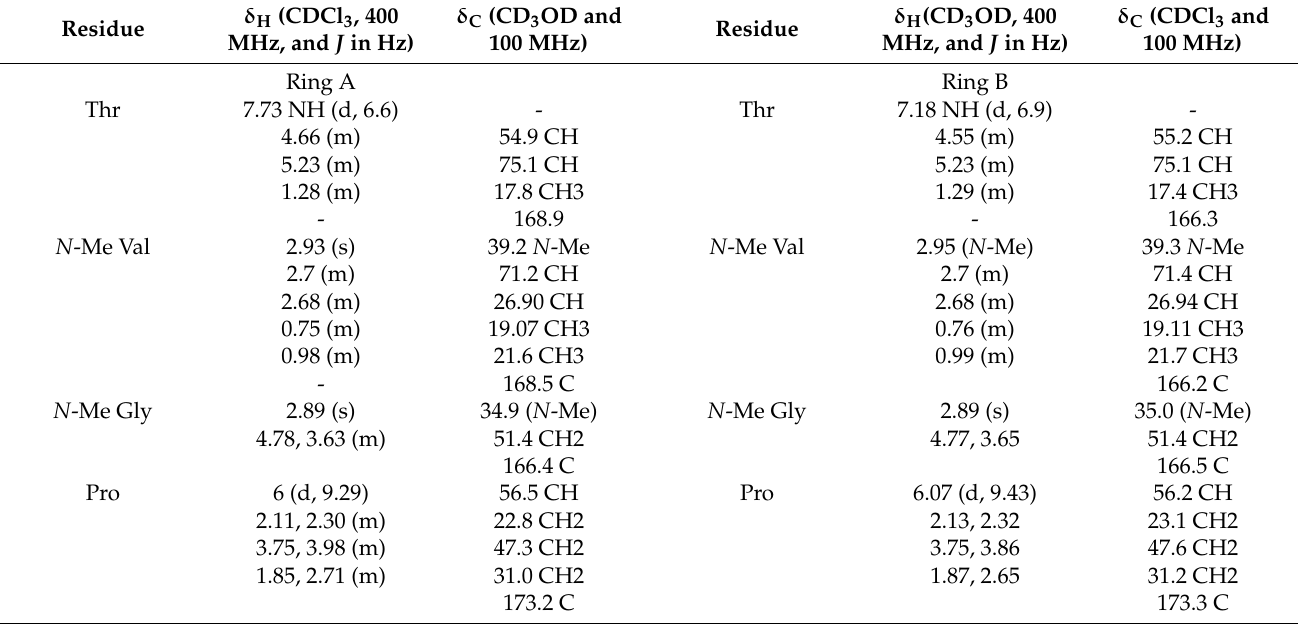
Table 4. One dimension NMR data of compound 4